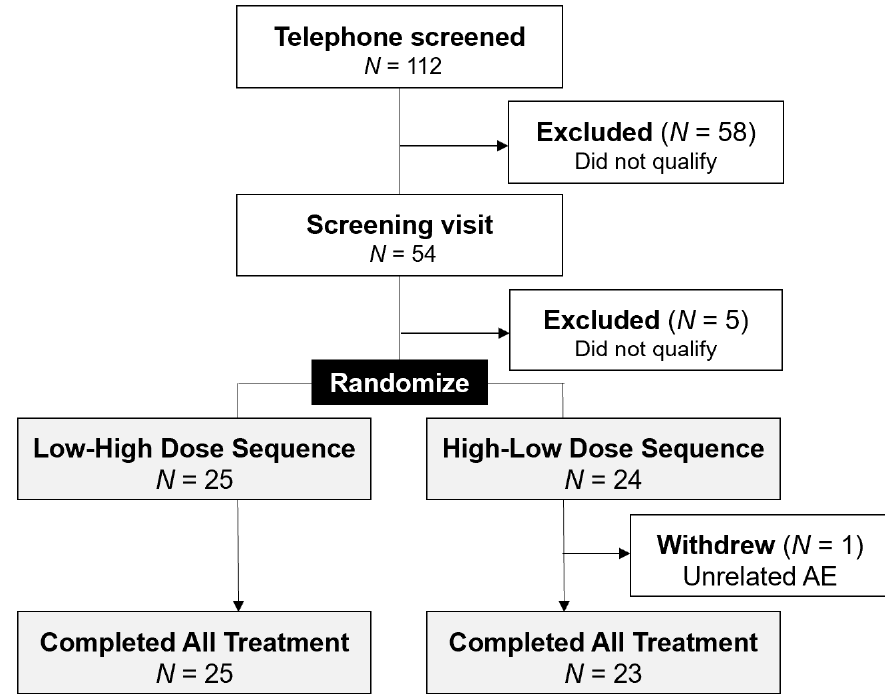
Figure 2. CONSORT diagram. Table 1. Baseline